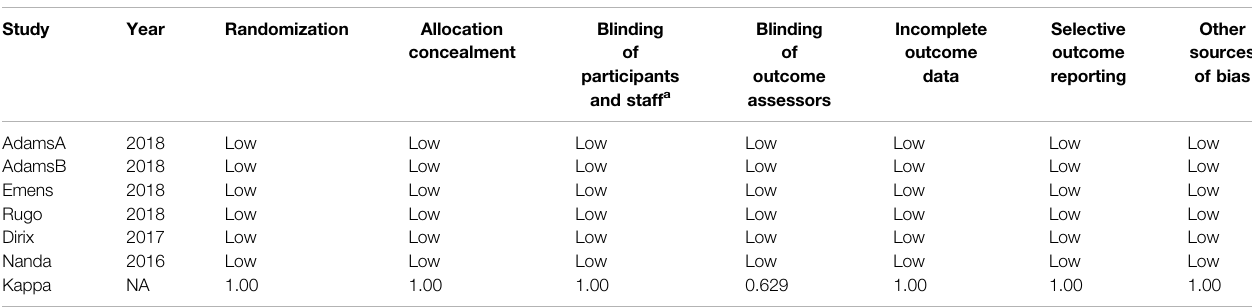
TABLE 2 | Risk of bias graph according to Cochrane risk of bias tool.